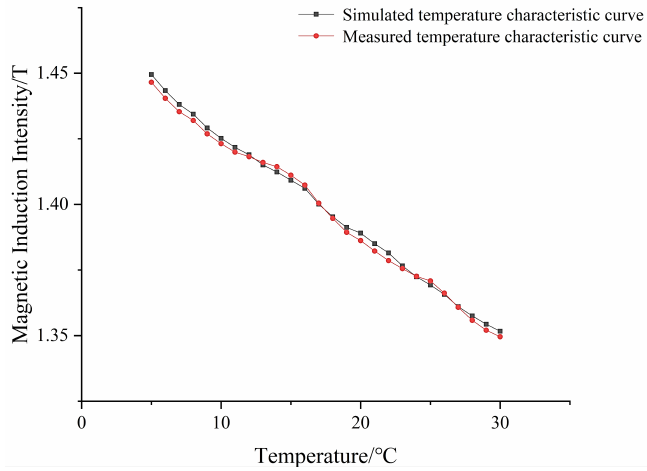
Figure 19. Comparison of the simulated and measured temperature characteristic curves.